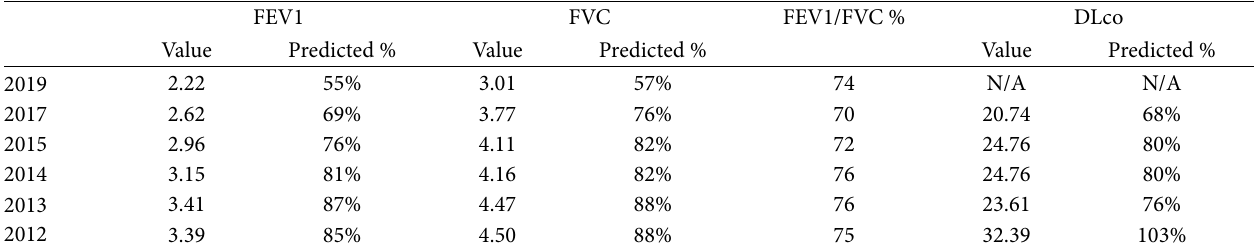
Table 1: Pulmonary function test over several